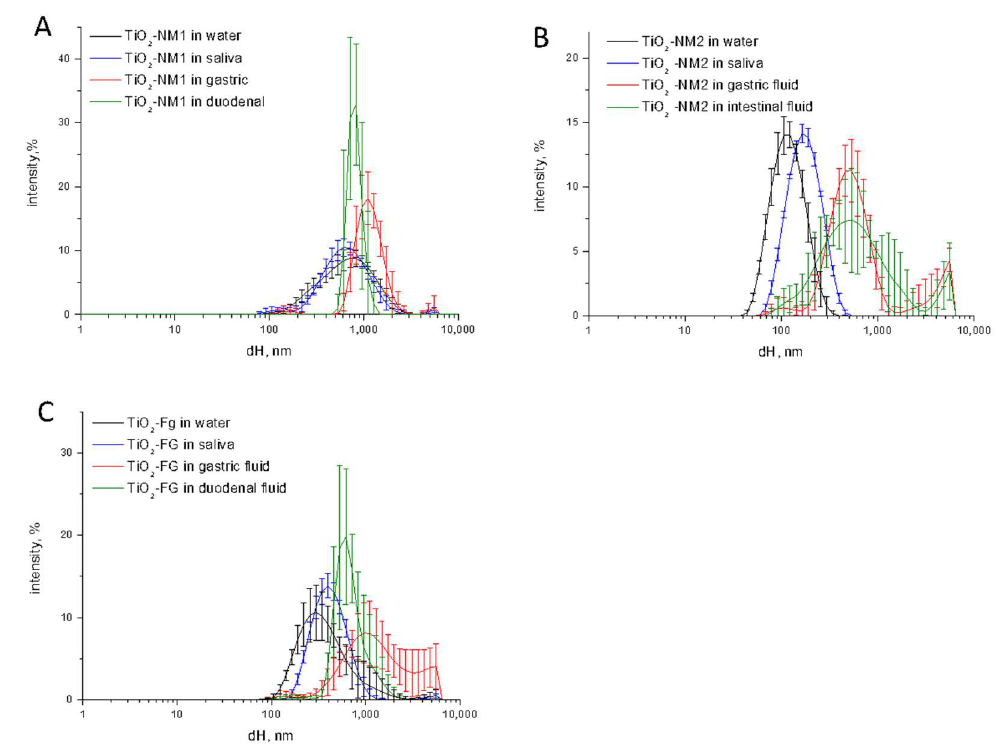
Figure 2. Size distribution monitored by DLS of the TiO 2 samples during the digestion cascade. ( A ) TiO 2 -NM1; ( B ) TiO 2 -NM2; ( C ) TiO 2 -FG. Hydrodynamic diameters (d H ) distribution (% intensity) is expressed as mean value of 5 measurements in three independent experiments ± SD.